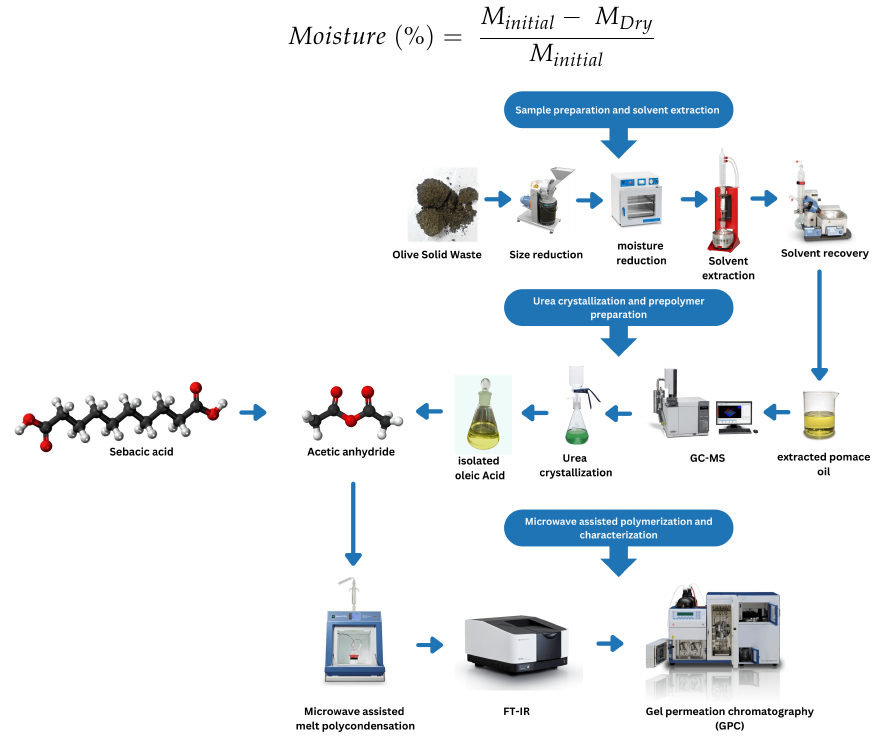
Figure 2. Schematic illustration of the experimental